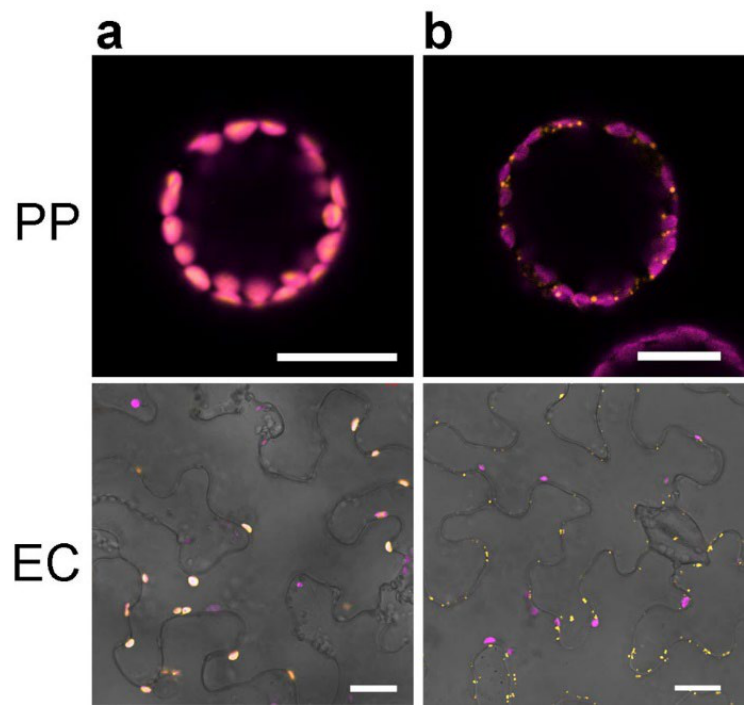
Figure 4. Subcellular localization of proteins located within plastids ( a ) and mitochondria ( b ). ( a ) Rubisco(1–79)–mCherry. ( b ) mtRi(1–100)–mCherry. Fluorescence of the transit peptide fusion with mCherry is shown in orange, whereas the autofluorescence of chloroplasts is depicted in magenta. To better visualize the location of the respective organelles in epidermal cells, the bright-field image was added. PP—protoplast, EC—epidermal cell. Bars represent 20 µ m in all micrographs. All the selected OMs were used to create the final Golden Gate vector set (Figure S2, Table 1). Using two versions of the GFP-encoding sequence (with and without stop codon), the possibility for N- and C-terminal fusions with the POI is given. Moreover, vectors for contain an Agrobacterium origin of replication, as well as right and left borders. The gene of the